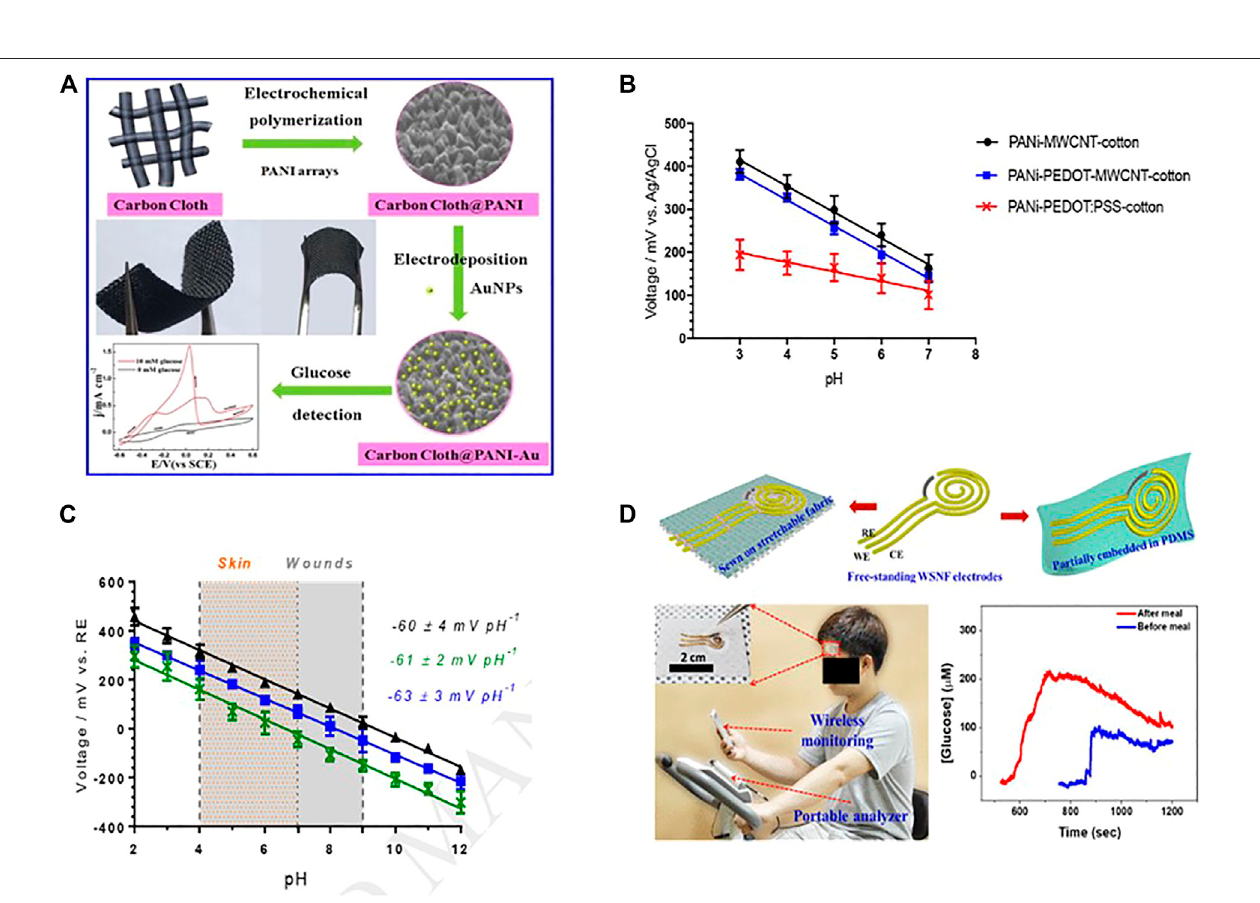
FIGURE 6 | (A) AuNPs/PANI/CC based non-enzymatic glucose sensor (Copyright 2017; Sensors and Actuators). (B) PANi-coated conductive cotton yarns ’ pH sensitivity, theerror bars show the standard deviation ofmeasurementon n (cid:2) 3replication fi bers (Copyright 2019;Sensors and Actuators). (C) An open circuit PH study potentiometric response of PANi-PEDOT-MWCNT-cotton electrodes. (Copyright 2019; Sensors and Actuators). (D) Schematic illustration of rGO/PU-Au nanocomposite fi ber used in manufacturing sweat-based wearable electrochemical glucose (Copyright 2019; American Chemical Society).